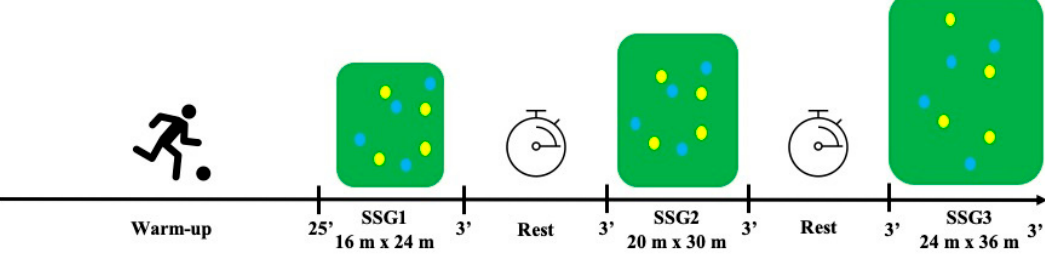
Figure 1. Schematic representation of the experimental protocol.